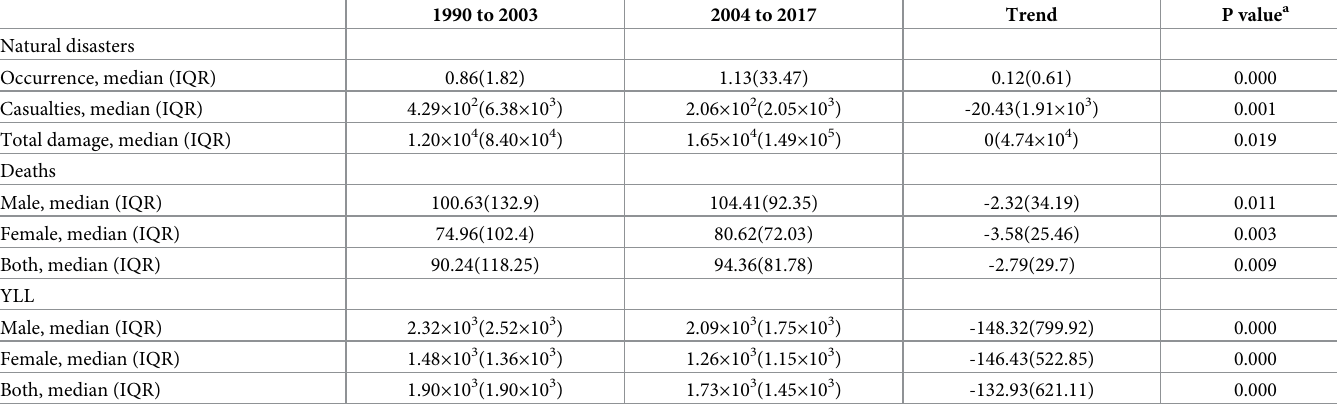
Table 1. Summary statistics for natural disaster impacts and mortality and YLL rates due to IHD during two periods in 193